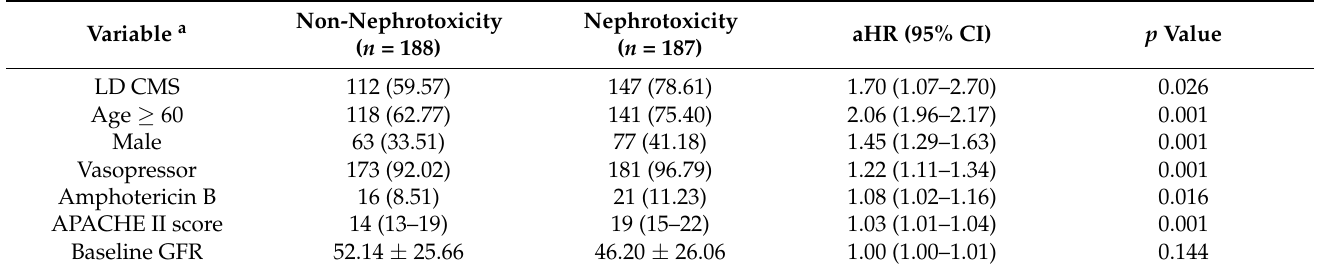
Figure 1. Forest plot of hazard ratios and 95 % confidence intervals of outcomes for critically ill patients receiving LD CMS and non - LD CMS therapy. Table 3. Multivariable Cox regression model for significant predictors of risk factors for nephrotoxicity among all critically ill